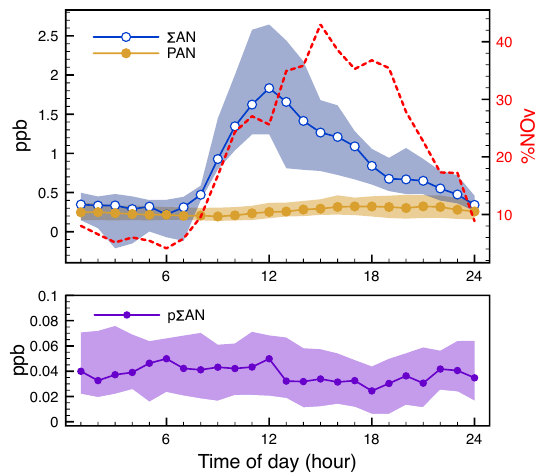
Figure 2. Average mixing ratios of total alkyl nitrate ( (cid:54) AN, blue), PAN (yellow), ( (cid:54) AN / NO y ) × 100% (red dashed) and p(cid:54) AN (purple) vs. time of day. Interquartile range is shaded.